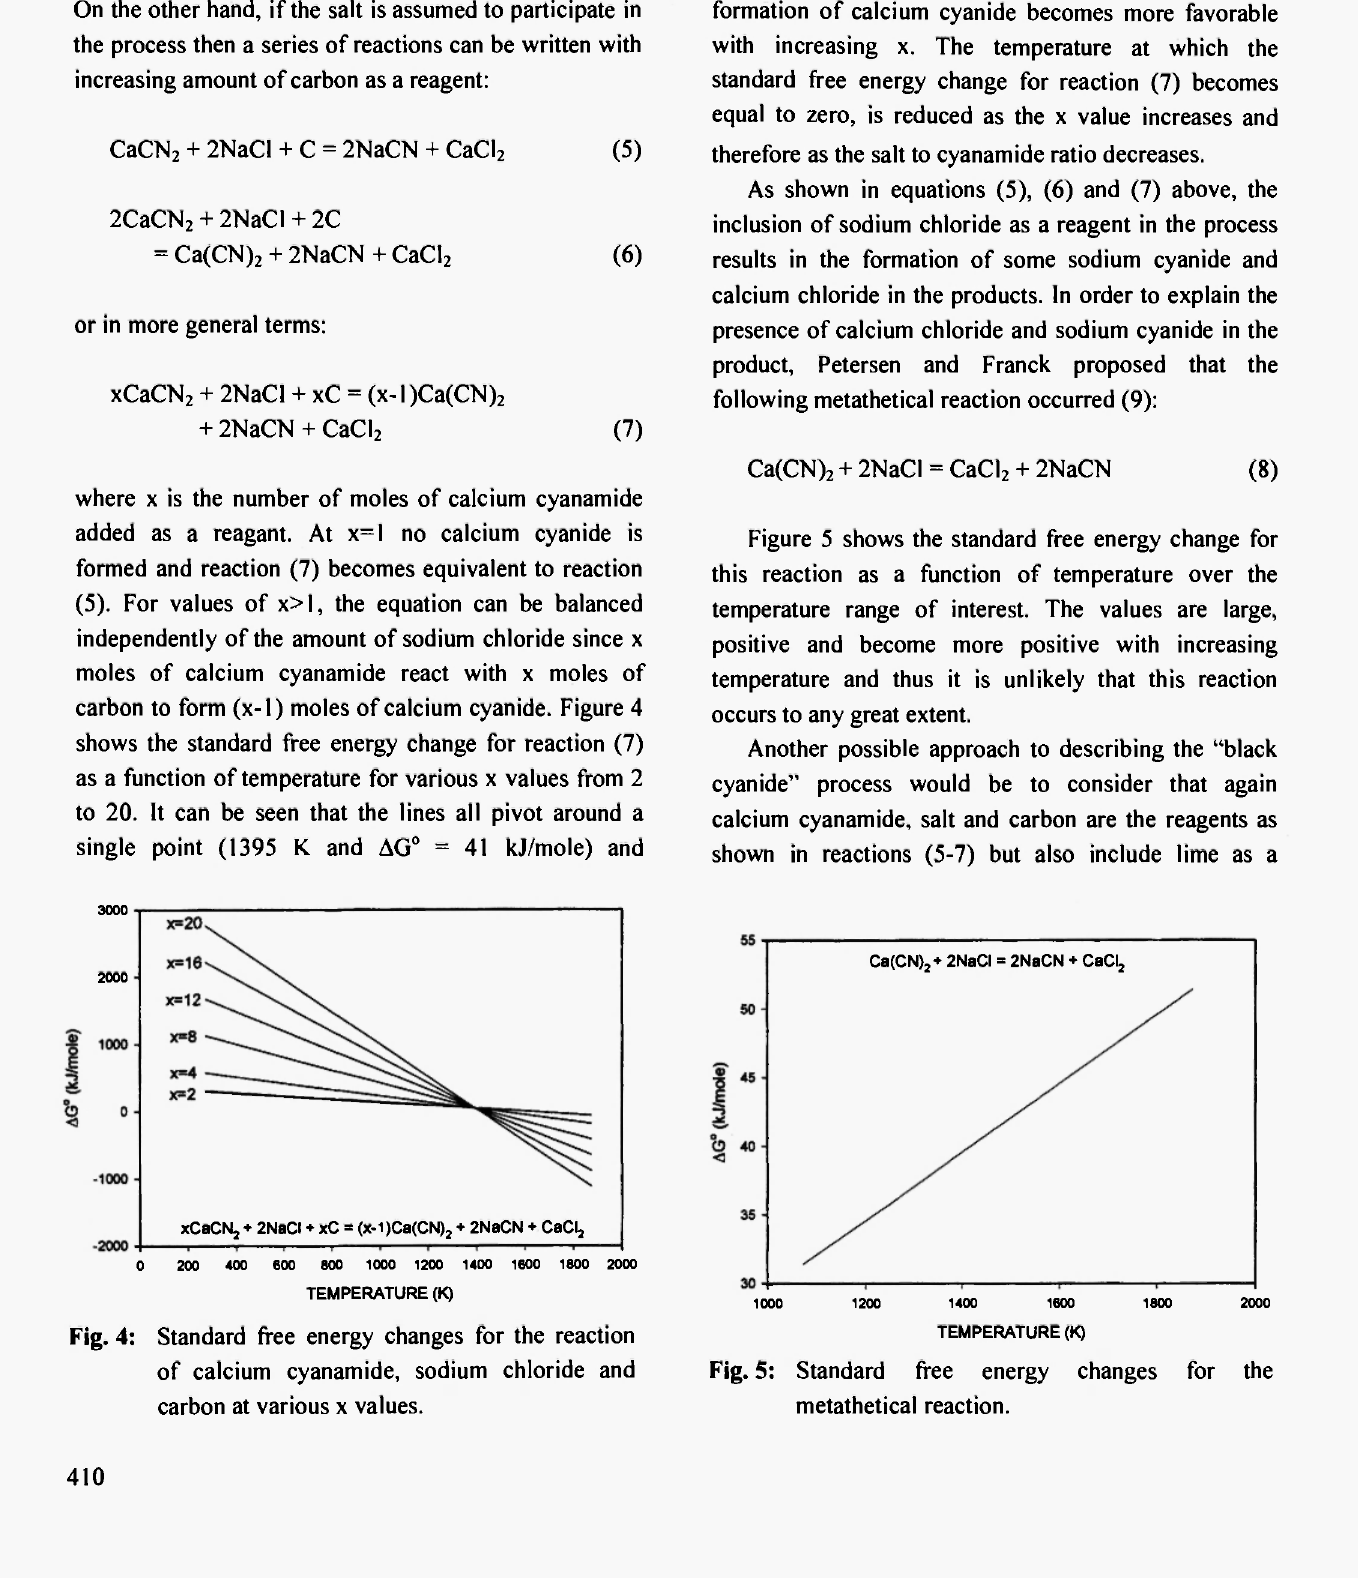
free energy changes for the metathetical